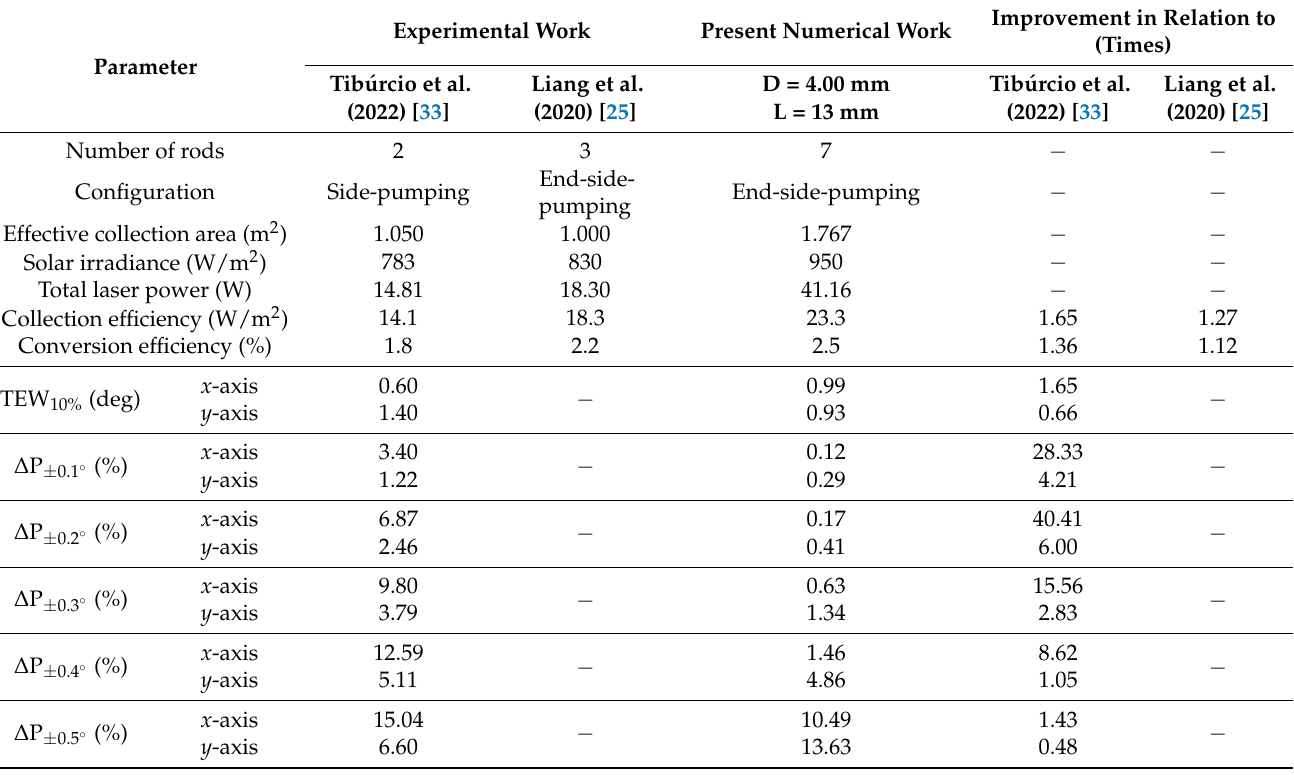
Table 3. Comparison between the results in multimode regime of the present work and the ones from the experimental works by Tib ú rcio et al. [33], and Liang et al. [25]. Improvement in Relation Experimental Work Present Numerical Work